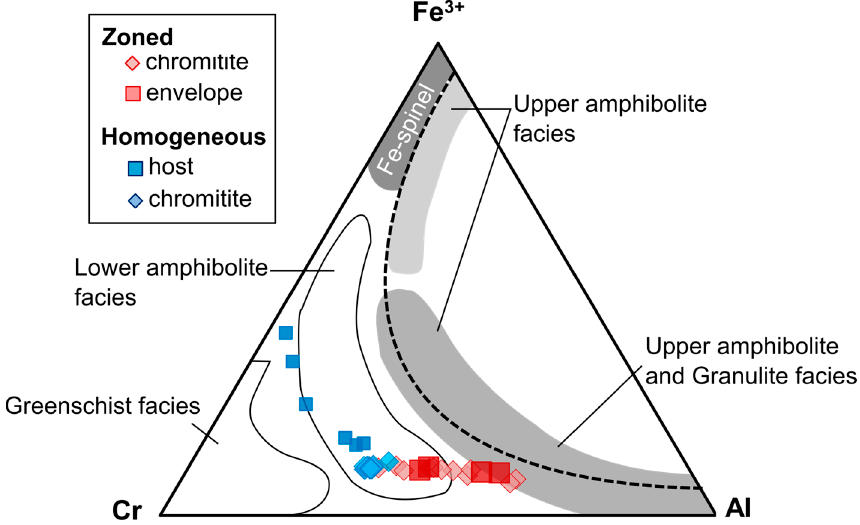
Figure 10. Cr–Fe 3+ –Al triangular plot of the Ulamertoq chromites with fields of metamorphic spinels from different metamorphic grades (fields taken from the data of Purvis et al. [43], Evans and Frost, [9], and Suita and Streider [44]).